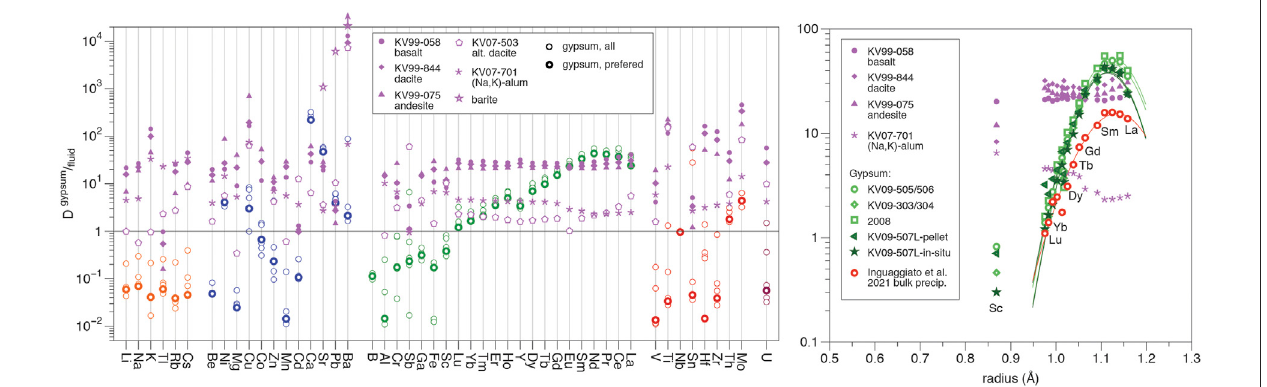
FIGURE 4 | (A) . Gypsum- fl uid element partition coef fi cients as determined from co-sampled pairs of actively growing gypsum and the fl uid from which it was growing. Element are ordered by charge and then increasing radius. The apparent fl uid partition coef fi cients for Kawah Ijen magmatic deposits, their altered equivalent (Na,K)-alum and barite are shown for comparison. The LREE and Sr are strongly compatible in gypsum, whereas the alkalis and HFSE are incompatible. (B) . Onuma diagramforthe3+elementsandLattice-StrainTheory(LST) fi tsthroughthesedataforgypsum(solidlines).AdherencetoLSTindicatesthatelementincorporation is controlled by the crystallography ofthe gypsum mineral structure. The ideal radiusderived from the LST fi t (1.118 Å) corresponds to thatof Ca 2+ in cubic coordination (1.12 Å), showing that the REE reside in the Ca site. The gypsum D-values presented here are higher than those of Inguaggiato et al. (2020), likely because of dilution of the gypsum REE content by the presence of other phases in the bulk-digested precipitate.